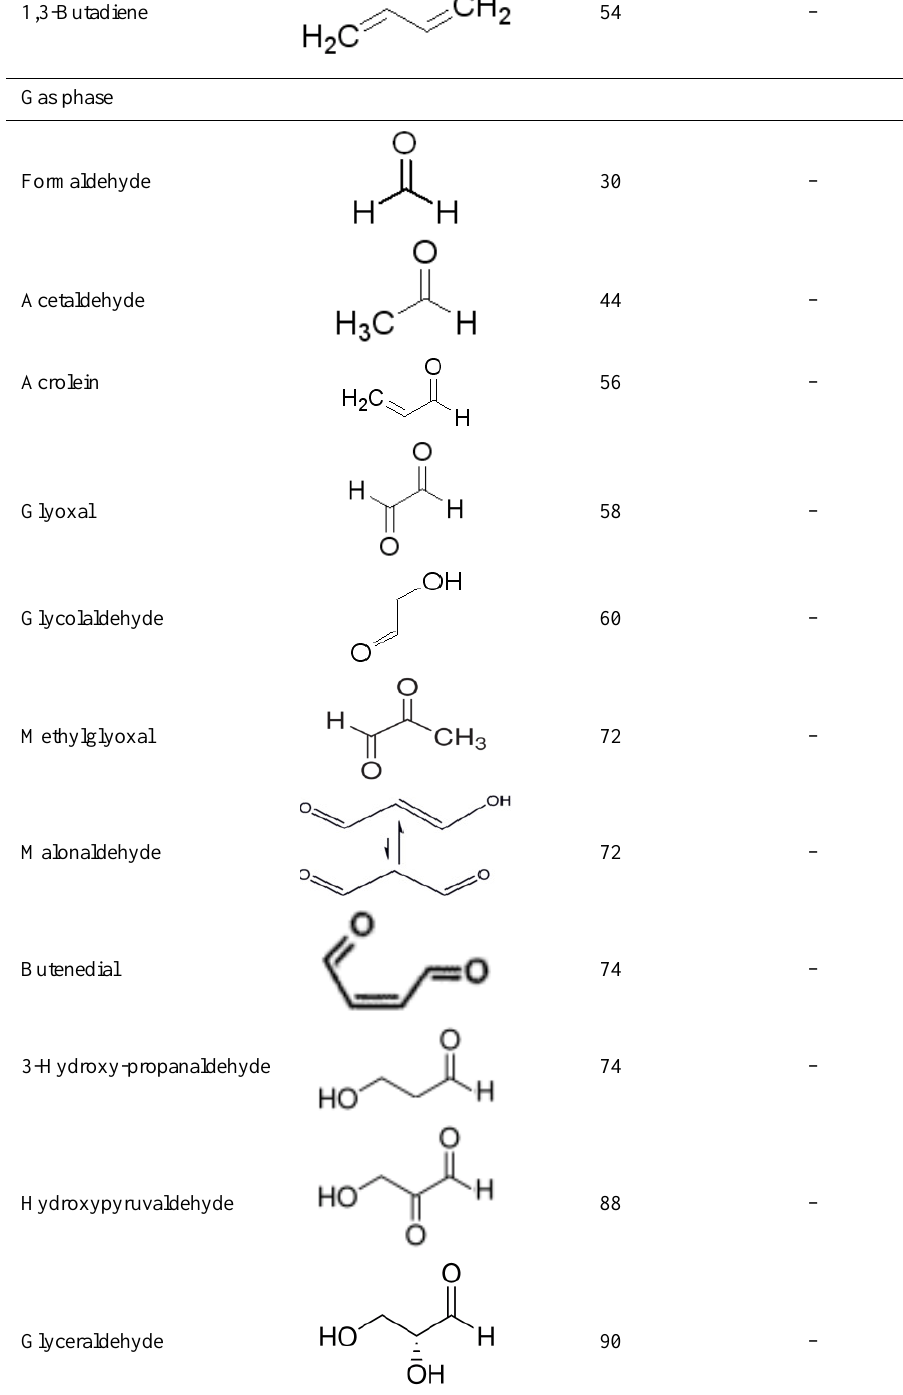
Table 2. Summary of gas-phase and SOA products generated from the oxidation of 1,3-butadiene. Oligoesters presented here are only one possible isomer.